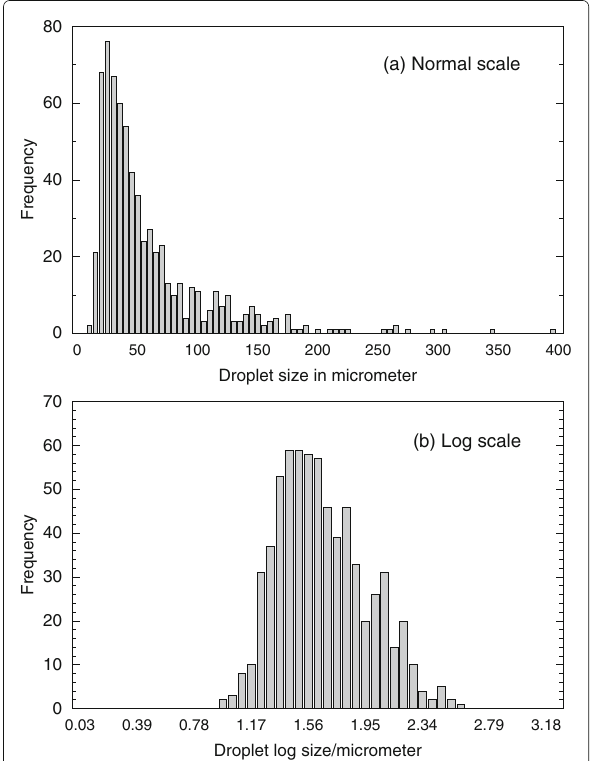
Fig. 5 Size-frequency distribution of silicate droplets recovered from run# SZ6. a Normal scale. b Common logarithmic